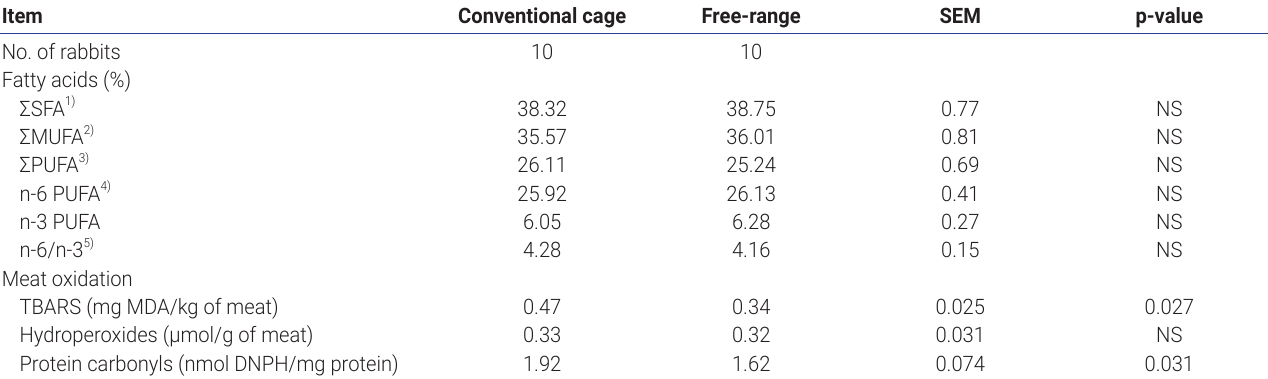
Table 4. Effect of rearing system on meat fatty acid composition (% FAME) and oxidation products of rabbits Item Conventional cage